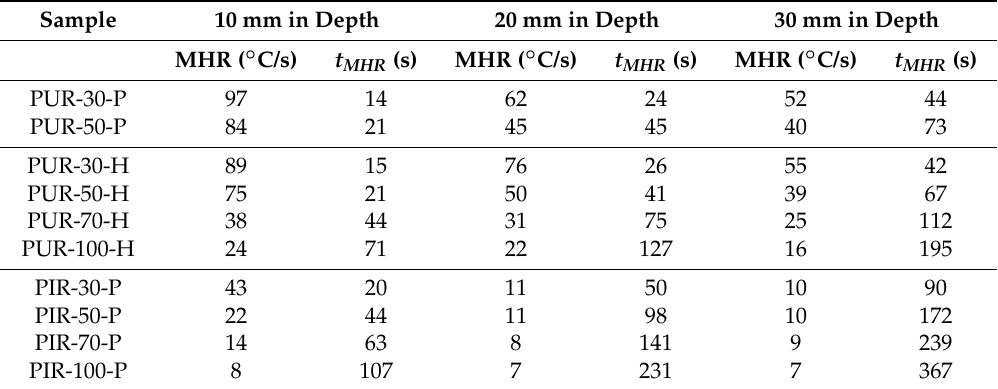
Table 7. Maximum heating rates at depths of 10, 20, and 30 mm for all tested